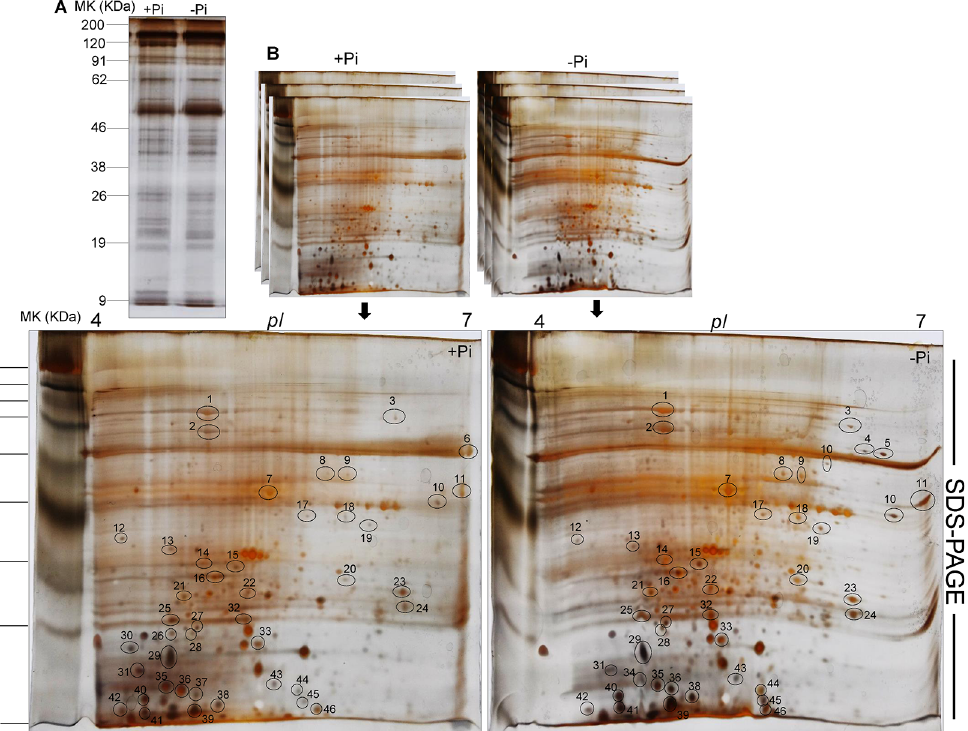
Fig 3. Protein profile in leaves of tomato ( Solanum lycopersicum L.) to Pi starvation. One week after germination tomato plants were supplied with sufficient Pi (1 M KH 2 PO 4 ) or deficient Pi (0 M KH 2 PO 4 ) for 10 days. (A) Comparative analysis of protein profile by first dimension SDS-PAGE for analysis of enrichment of proteins (B) Comparison of 2-DE gel maps of proteins. The proteins were extracted using a commercial available kit and 100 μ g protein samples were separated by isoelectric focusing (IEF) using 11 cm pH 4 – 7 IPG strips. The focused strips were placed on a 12% polyacrylamide gel for second-dimensional separation and stained with silver stain. The gel image analysis was carried out using PDQuest software. The encircled protein spots marked with numbers were differentially expressed. All differentially protein spots were identified by MALDI-TOF MS listed in Table 1.